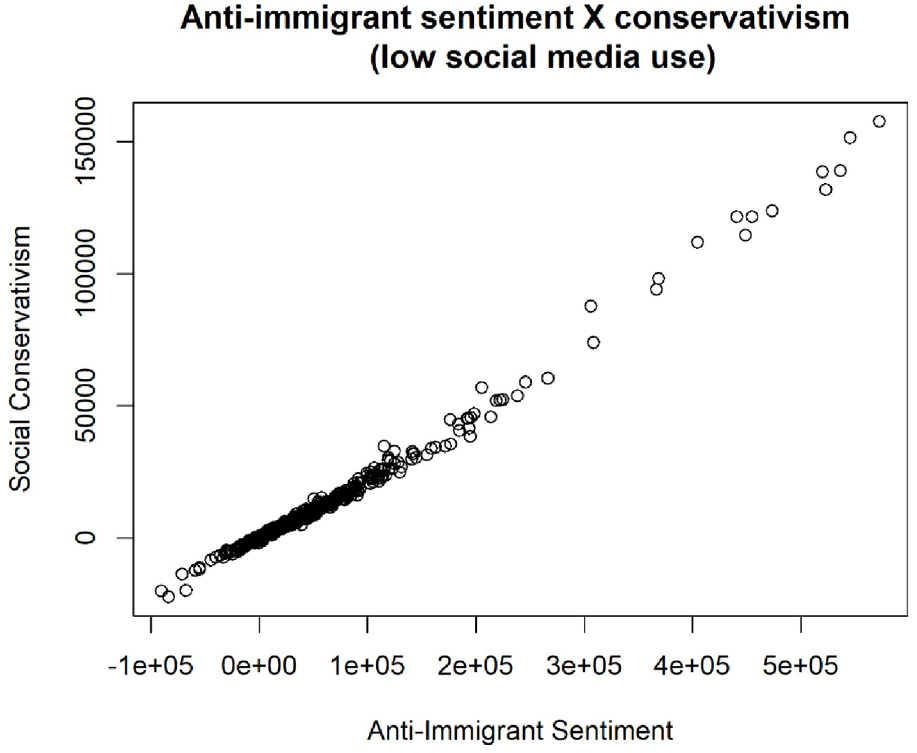
Fig 18. Cluster plot of social conservativism (ring wing social values) and anti-immigrant sentiment.